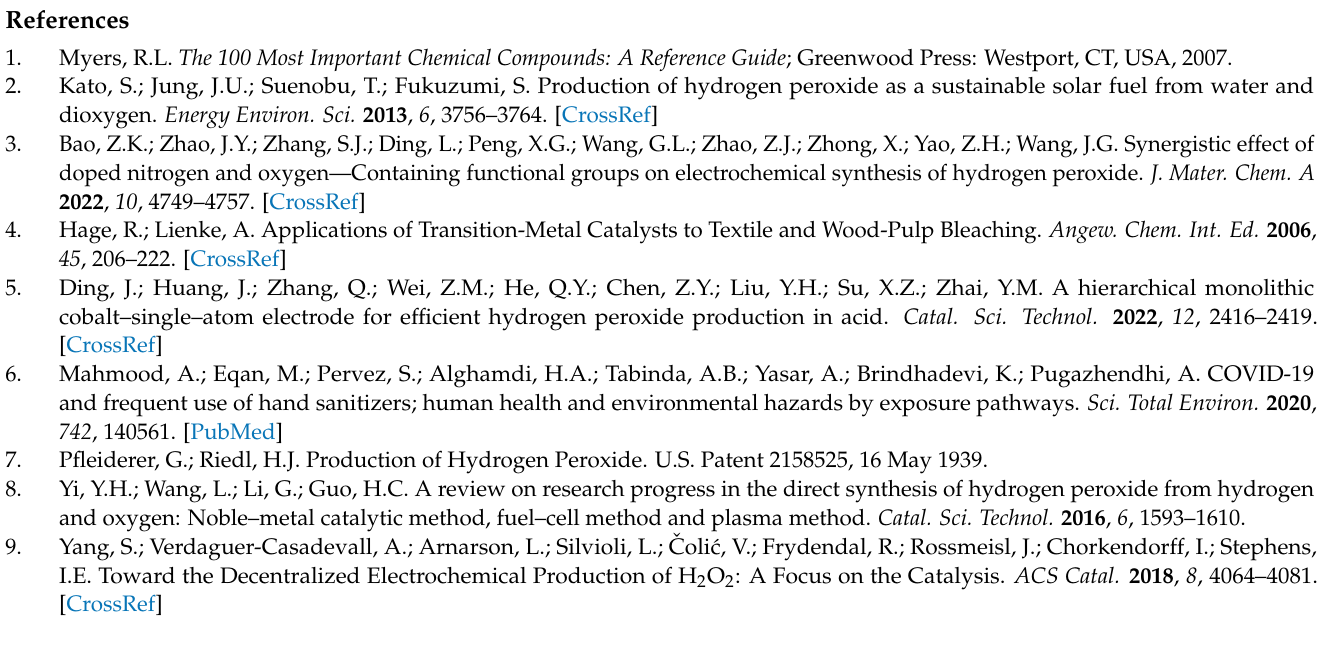
and 50 mV s − 1 in N 2 and O 2 saturated electrolyte. (a) NPC-900. (b) O-NPC-80. (c) O-NPC-100. (d) O-NPC-120. All dashed lines: N 2 ; all solid lines: O 2 ; Figure S5: LSV curves of (a) NPC-900, (c) O-NPC-80, (e) O-NPC-100, (g) O-NPC-120 measured at different rotation speeds in O 2 saturated 0.1 M KOH. (b) NPC-900, (d) O-NPC-80, (f) O-NPC-100, (h) O-NPC-120 are Koutecky − Levich plots based on corresponding LSV curves; Figure S6: Effect of O-NPC-120 loading on catalytic performance of 2e − ORR. (a) RRDE polarization curve. (b) electron transfer number. (c) H 2 O 2 selectivity; Figure S7: Cyclic voltammogram in the non-faradic potential region at varying scan rates for the samples of (a) NPC-900. (b) O-NPC-80. (c) O-NPC-100. (d) O-NPC-120; Figure S8: LSV curves of O-NPC-120 in 0.1M KOH solution with H 2 O 2 concentrations of 0 mM, 1 mM, 2 mM, and 3 mM; Figure S9: (a) UV-Vis spectra of Ce 4+ solutions with different concentrations. (b) is the standard curve corresponding to (a).Figure S10: i-t curves of O-NPC-120 in 0.1 M KOH electrolyte under different voltages. (a) 0.26 V. (b) 0.36 V. (c) 0.46 V. Loading capacity of catalyst: 100 µ g/cm 2 ; Figure S11: The XPS-characterized C1s spectra of (a) NPC-900, (b) O-NPC-80 and (c) O-NPC-100, respectively; Figure S12: O1s spectra characterized by XPS (a) NPC-900, (b) O-NPC-80 and (c) O- NPC-100, respectively; Figure S13: N1s spectra characterized by XPS (a) NPC-900, (b) O-NPC-80 and (c) O-NPC-100, respectively; Table S1: C, N, O contents of catalysts detected by XPS; Table S2: Different C types and contents in catalysts determined from XPS analysis results; Table S3: Different O types and contents in catalysts determined from XPS analysis results; Table S4: Different N